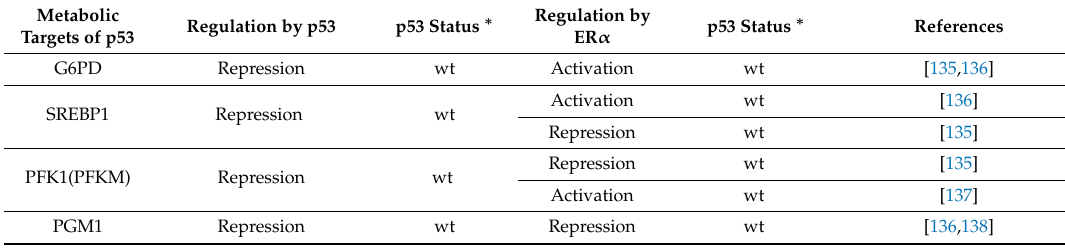
Table 1. List of genes and proteins regulated by both ER α and